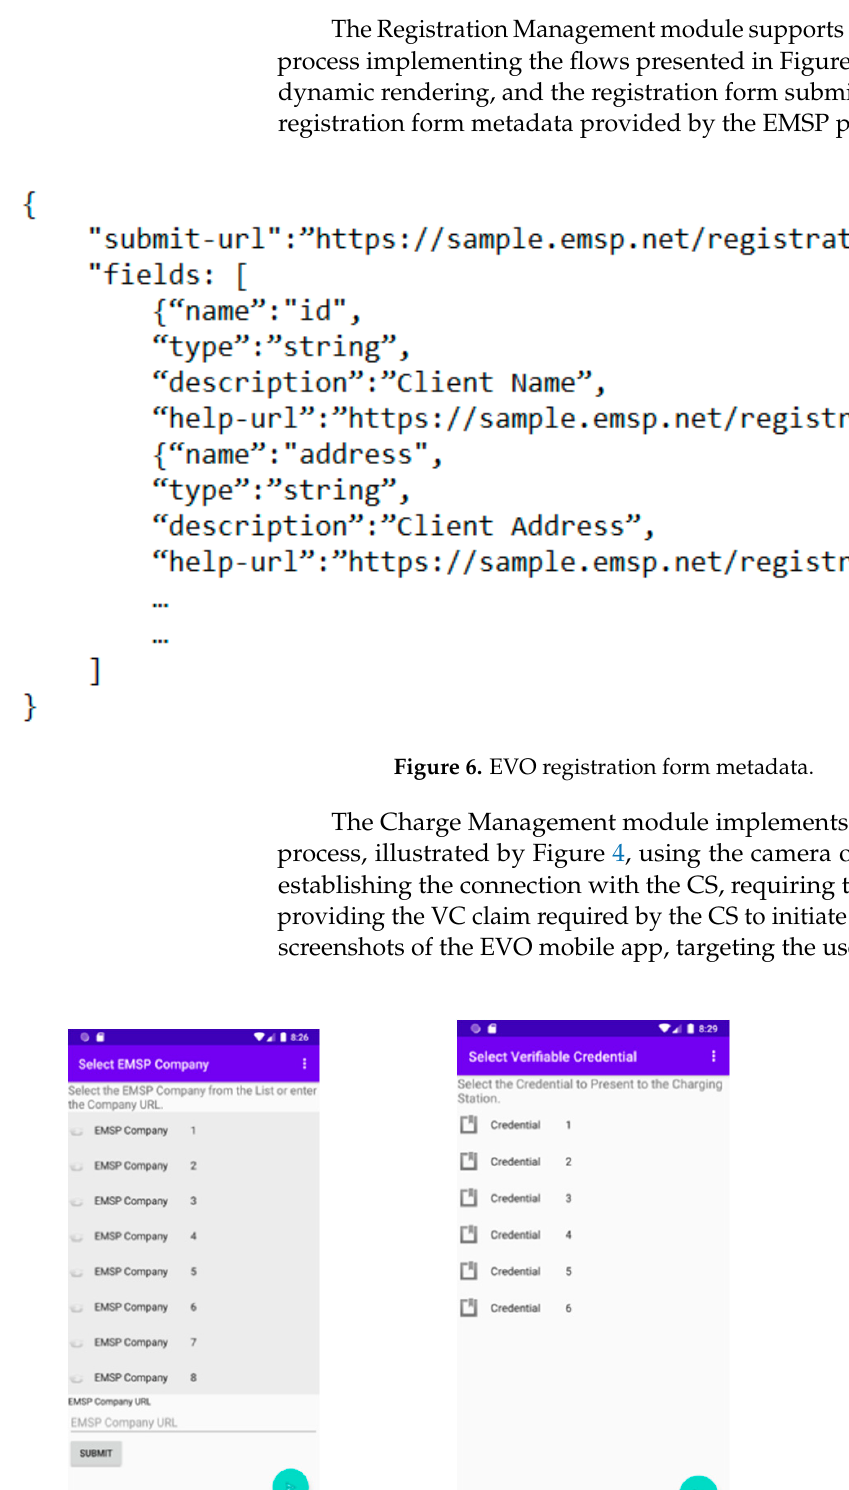
Figure 7. The EVO mobile app screenshots. ( a ) Selection of provider company for registration. ( b ) Selection of verifiable credential. ( c ) Accepting disclosure information.